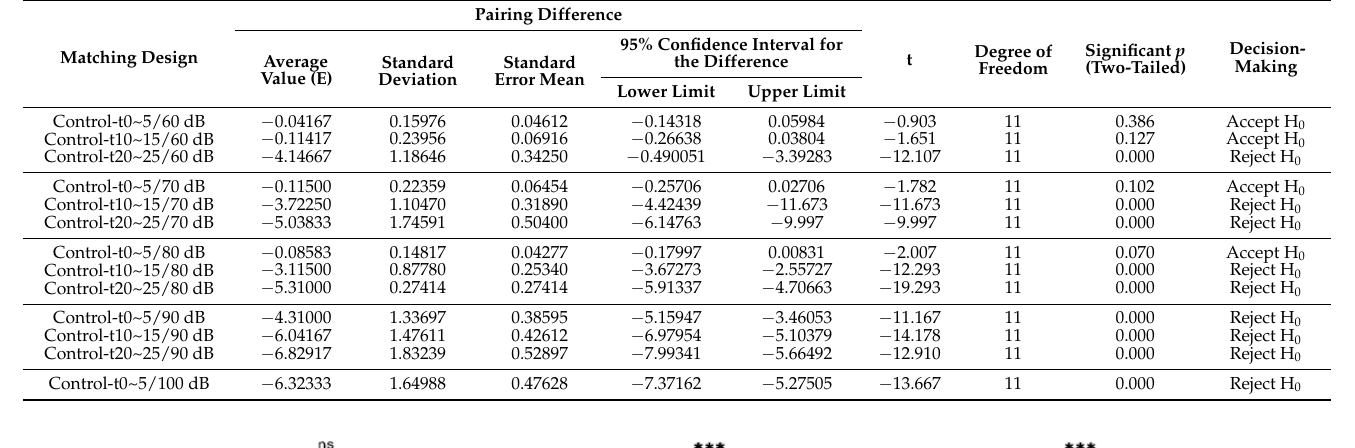
Table 4. Paired sample t -test results of skin conductivity.